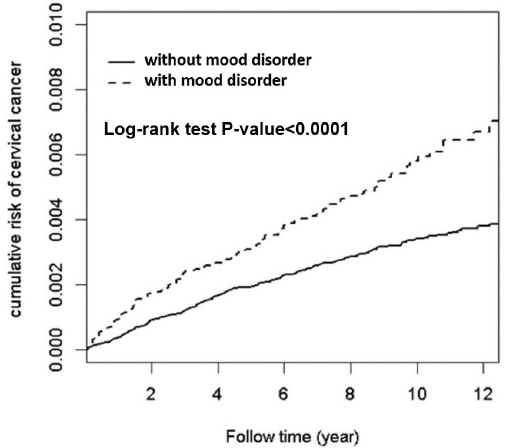
Figure 2. Kaplan–Meier survival curves compared the cumulative risk of cervical cancer between cohorts with and without mood disorders. The KM survival curves showed a higher cumulative risk of cervical cancer in the cohort with mood disorders compared to the cohort without mood disorders.